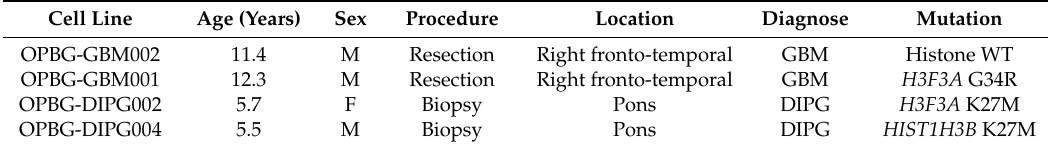
Table 1. Summary of demographic and clinical info of patient-derived cell